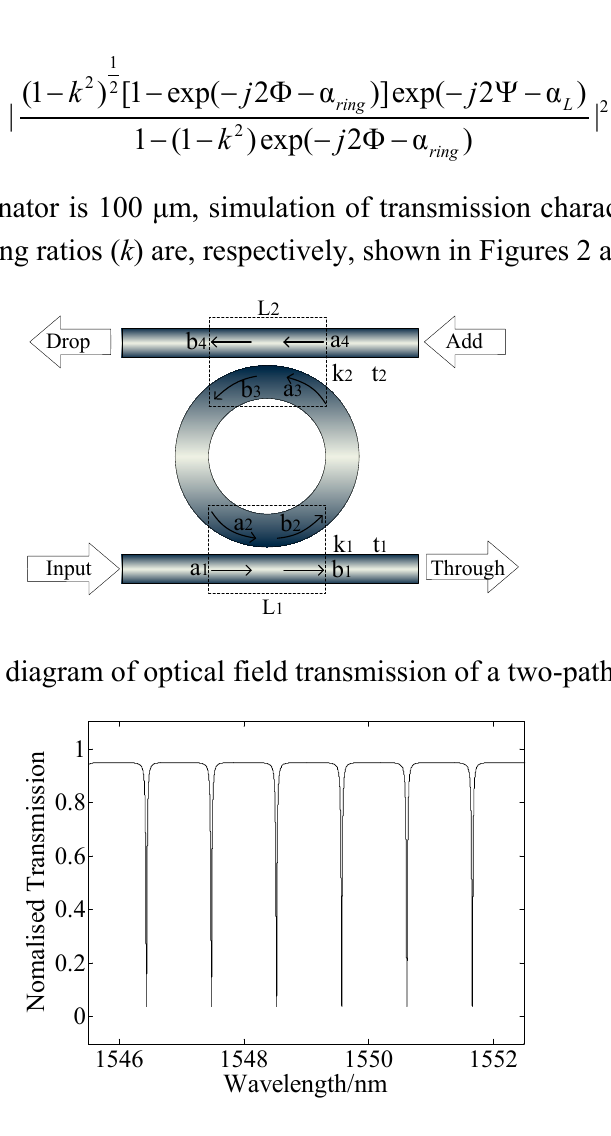
Figure 2. Resonance spectrum of ring resonator ( R = 100 μm).